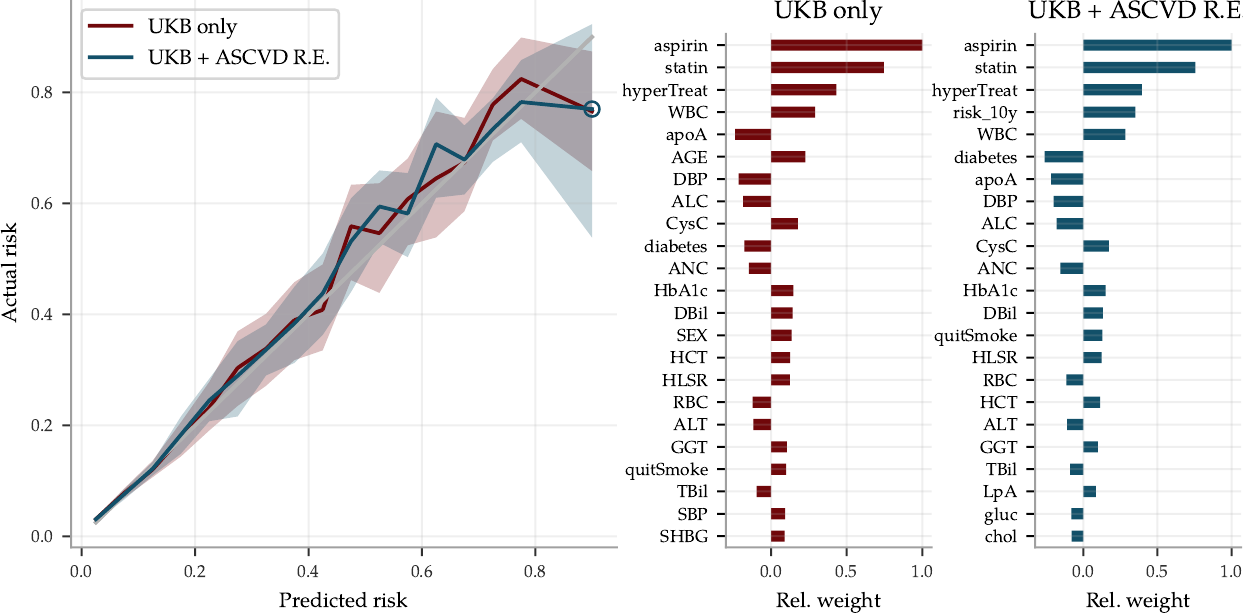
Figure 12. The risk prediction using both 62 biomarkers and all the ASCVD Risk Estimator input improves performance as compared to Figure 11, in particular for high risk individuals, and is very good all the way up to risk levels of 80%. The figure compares two predictors: a combined ASCVD predictor using all 62 biomarkers plus all the input fields (age, sex, etc.) used by the ASCVD Risk Estimator, using UKB data only, and a predictor using the same input plus the ASCVD Risk Estimator output , labeled UKB + ASCVD R.E. The latter does not perform notably better, although the ASCVD Risk Estimator output “risk_10y” corresponds to the fourth strongest coefficient. Both perform better than both the BMRS and ASCVD Risk Estimator individually, confirming their complementary nature shown in the heat map in Figure 11. The shaded areas in the left panel again indicate 95% confidence intervals obtained by 100 fold bootstrap calculations of the actual prevalence in each risk bin. Figures with all coefficients can be found in the Supplementary